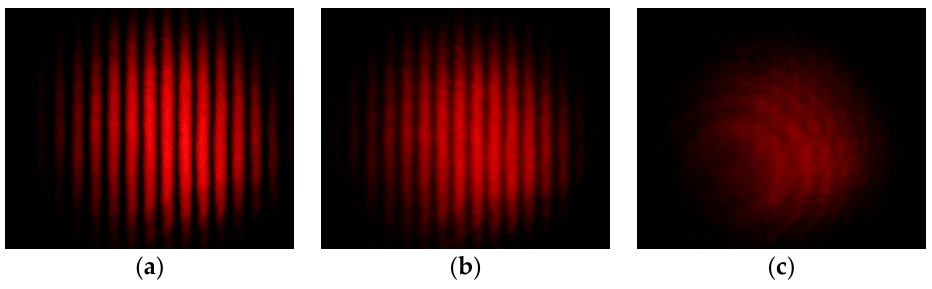
Figure 4. Photographs of interference patterns. The parameter was the concentration of fructose-water